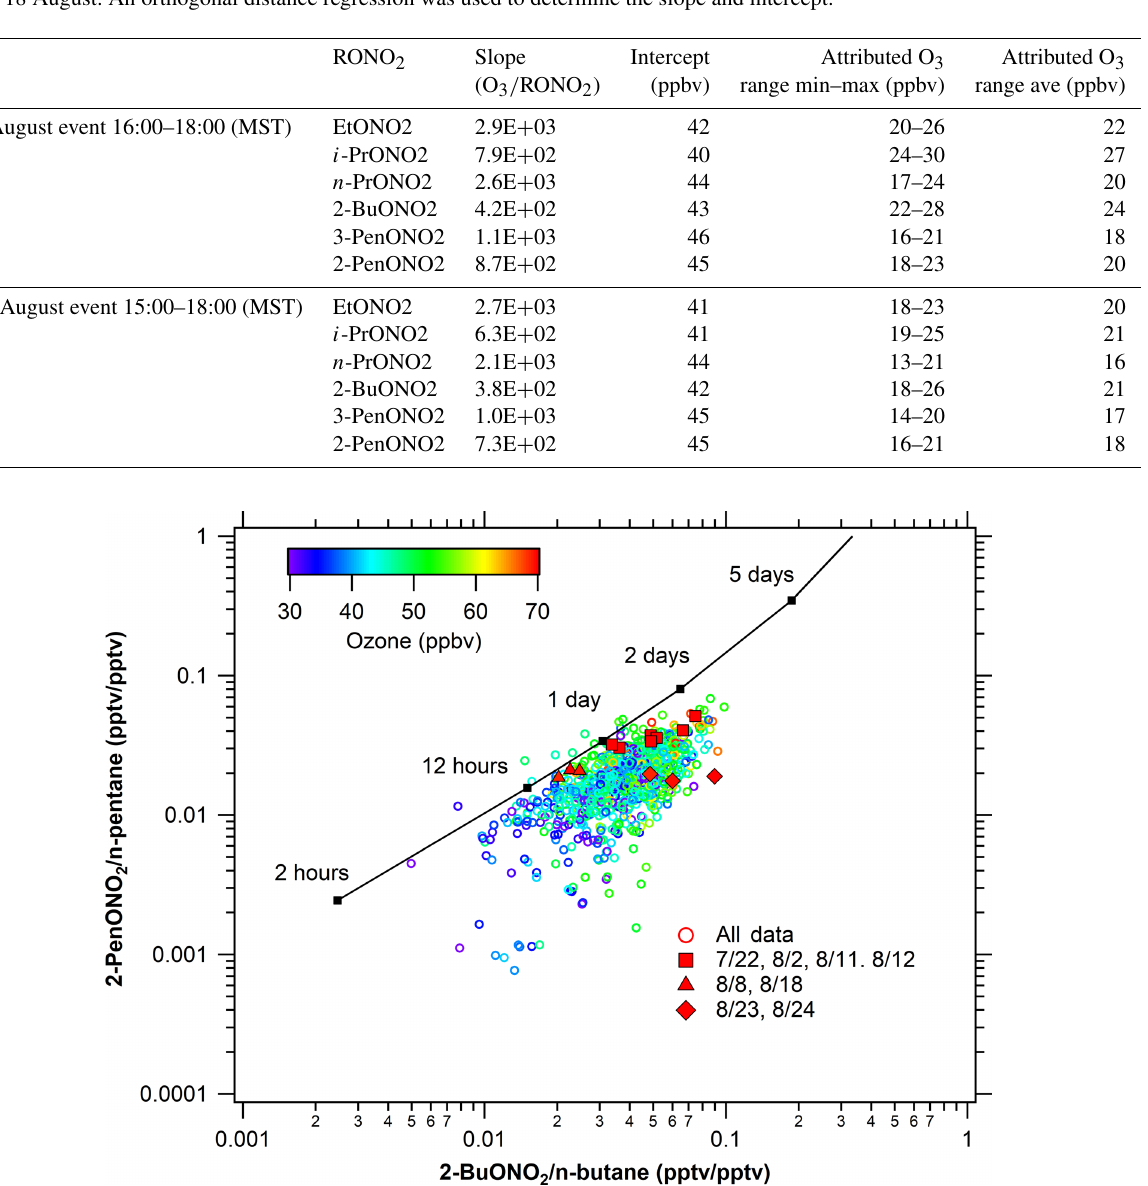
Figure 13. Photochemical age of alkyl nitrates. Comparison of observed alkyl nitrate: parent hydrocarbon ratios to predicted values provide an estimate of photochemical